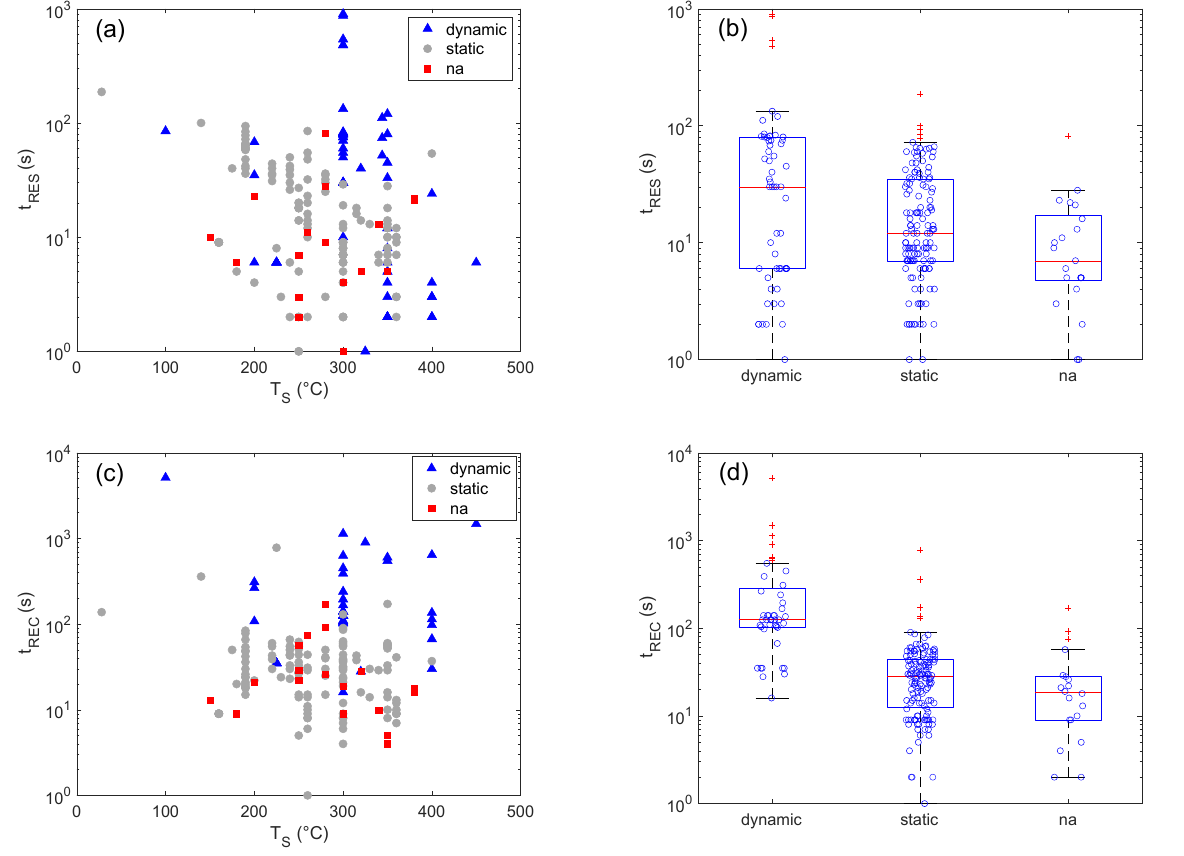
Figure 3. Sensor temperature and measurement setup effects on the response and recovery times. Plot of response time values vs sensor temperature ( a ) and related boxplot ( b ). Plot of recovery time values vs sensor temperature ( c ) and related boxplot ( d ). In ( a , b ), colors indicate the different measurement setups, and ‘na’ stands for ‘not available’—for those papers that did not provide enough detail to properly classify the measurement method.